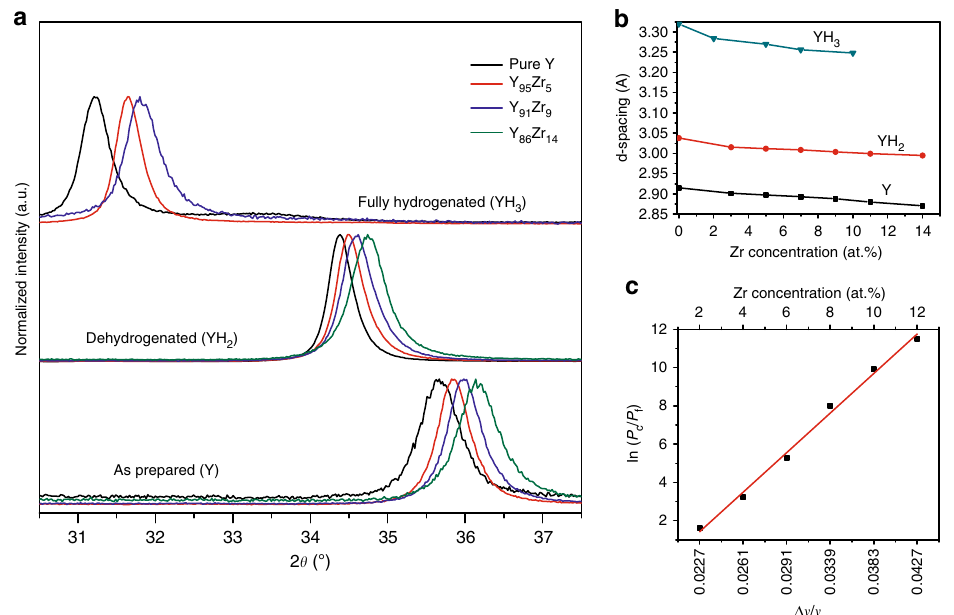
Fig. 2 Lattice behavior of YH x as a function of the Zr doping. a XRD pattern of Y – Zr thin fi lms showing the hcp-Y(002) diffraction peak in the as-prepared, fully hydrogenated hcp-YH 3 (002) and dehydrogenated YH 2 (111). The position of the peak clearly depends on the Zr concentration. Note that the Y 86 Zr 14 sample could not be fully hydrogenated to YH 3 even when applying 10 bar H 2 for 24 h. b Change in the corresponding YH x d-spacing as a function of the Zr concentration in the as-prepared, fully hydrogenated (YH 3 ), and dehydrogenated (YH 2 ) state. c Relation between the relative change in molar volume ( Δ V / V ) of YH 2 and the plateau pressure at the YH 2 ↔ YH 3 phase transition comparing uncompressed ( P f ) and compressed ( P C ) YH